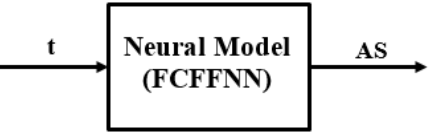
Figure 24. The general structure of the two neural models (represented under the “black-box” form). The input signal in the two neural models is the time [0; 40] ms, with the associated step ∆ t = 1 ms, resulting in 41 samples. Moreover, the output signal from the two neural models is the approximated signal (AS) which can be V R (t) (in the case of the voltage dynamics approximation during the fault propagation) or I R (t) (in the case of the current dynamics approximation during the fault propagation). For training the two neural models, the experimental data presented in Table 1, columns 2 and 3, are used (the data from column 2 for the current dynamics approximation and the data from column 3 for the voltage dynamics approximation). For modeling the two mentioned signals the used neural model is a fully connected feed-forward neural network (FCFFNN). In both cases, the neurons from the hidden layer are nonlinear ones, having bipolar sigmoid (hyperbolic tangent) transfer functions and the output neuron (in both cases, the output layer contains only one neuron) is a linear one (having linear activation function). For training, in both